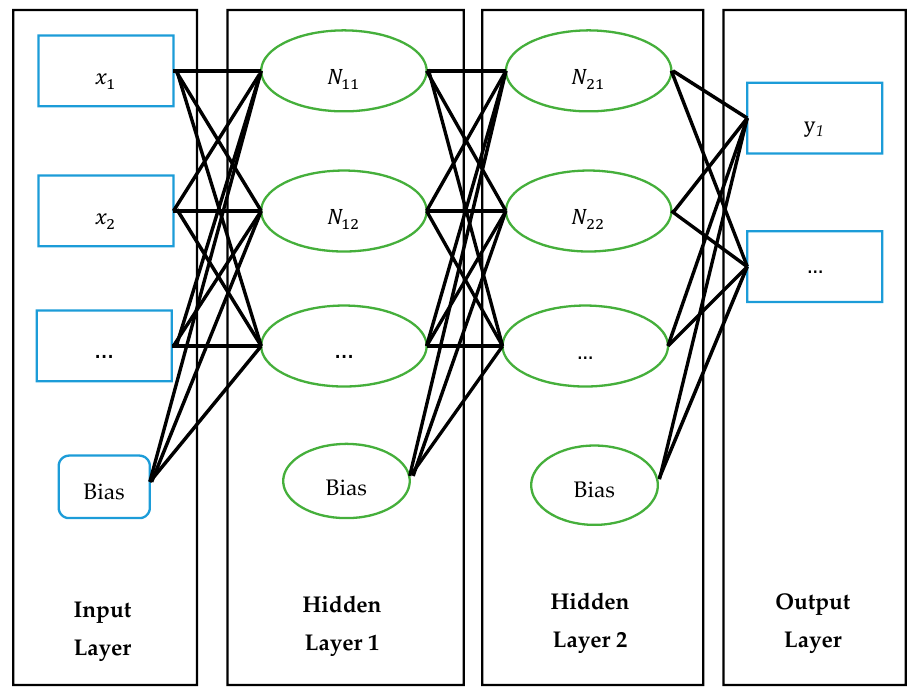
Figure 4. The architecture of artificial neutral networks (ANNs) model.